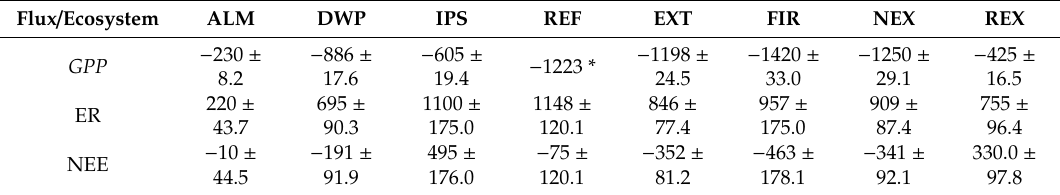
Table 4. Average annual carbon fluxes (gC m − 2 y − 1 ) and CI (95%) for di ff erent ecosystem types. Flux / Ecosystem ALM